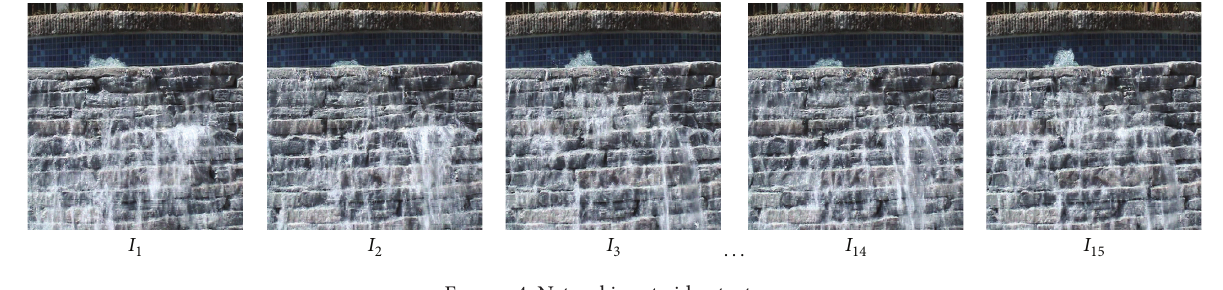
Figure 4: Natural input video texture. Table 1: L2 distance between the first frame and others.